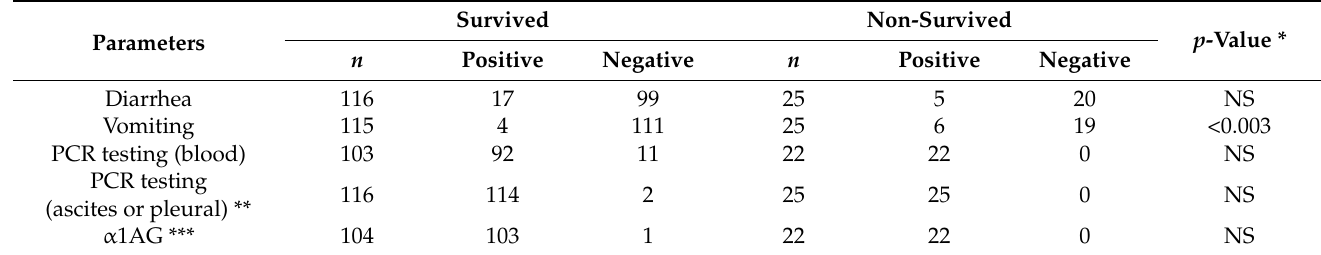
(Table 3). Ages, body weight, HCT, A/G ratio, and SAA levels were comparable between the two groups. However, body temperature ( p < 0.0005), appetite score ( p < 0.0001),